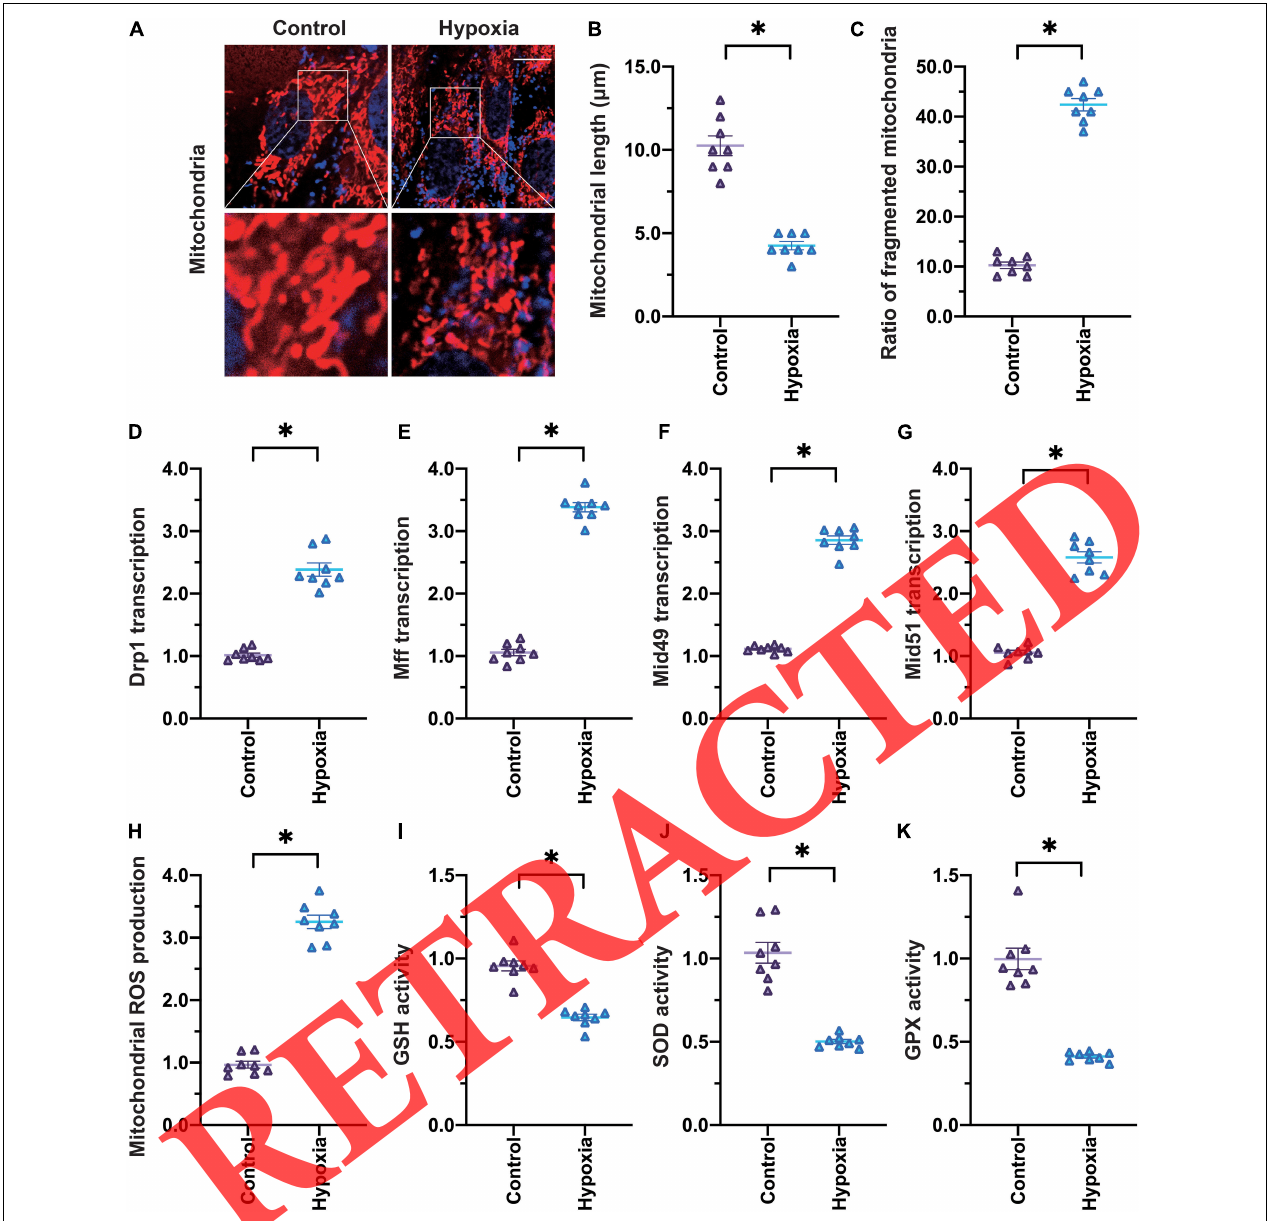
FIGURE 1 | Hypoxia induces mitochondrial division and oxidative stress in cardiomyocytes. (A–C) Cardiomyocytes were subjected to hypoxia to mimic myocardial infarction in vitro , and an immunofluorescence assay was used to detect the mitochondrial morphology. The average length of the mitochondria and the percentage of fragmented mitochondria were recorded. (D–G) qRT-PCR was used to analyze the transcription of Drp1 , Mff , Mid49, and Mid51 in cardiomyocytes subjected to hypoxia. (H,I) MtROS were detected through an immunofluorescence assay. (J,K) ELISAs were used to analyze anti-oxidative enzyme activity. * p < 0.05 vs. control